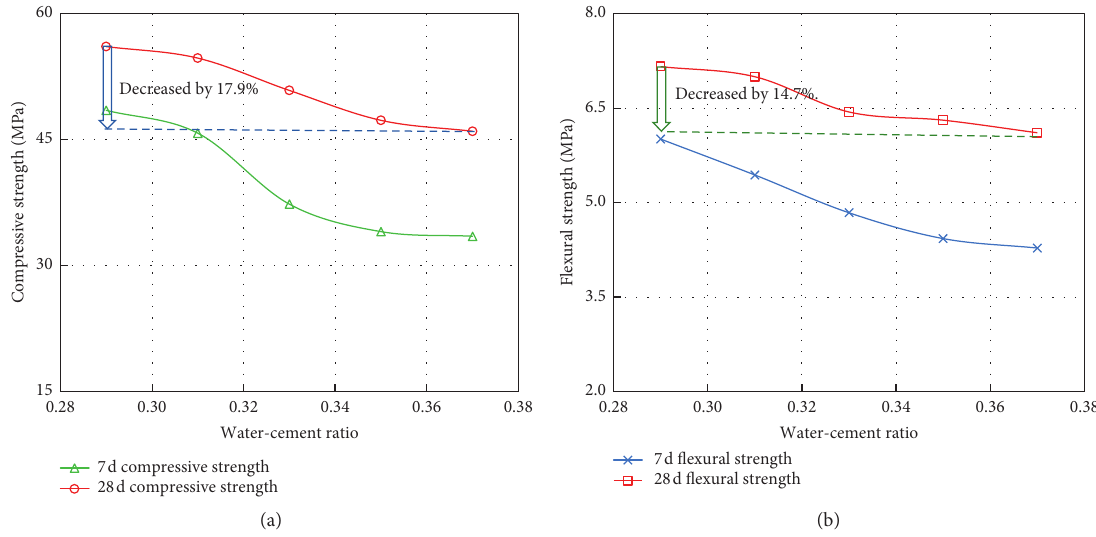
Figure 4: Strength of recycled aggregate concrete with different water-cement ratios. (a) The compressive strength. (b) The flexural tensile